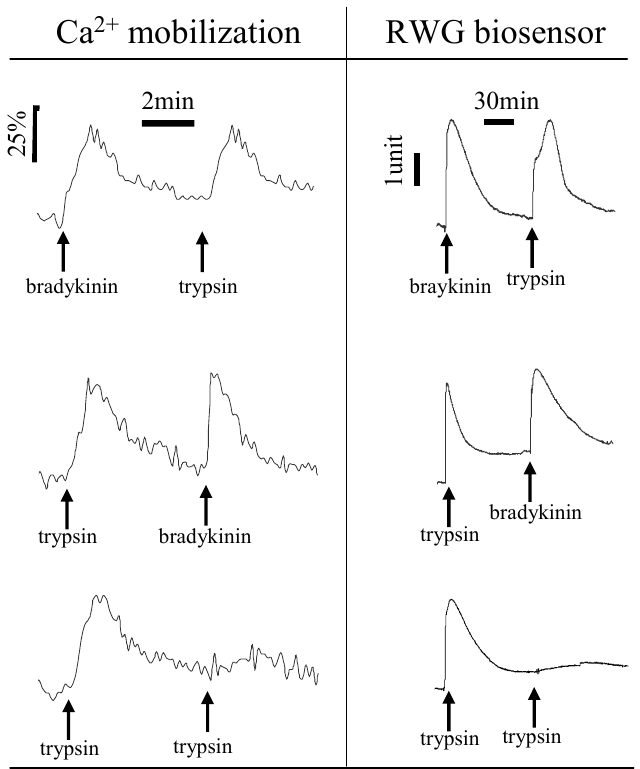
Figure 6 . GPCR agonist-induced DMR signals follow classical desensitization patterns, similar to those measured with Ca 2+ mobilization assays. A431 cells responded to repeated stimulation with distinct combinations of two agonists: bradykinin and trypsin, for endogenous B receptor and protease 2 activated receptor subtype 2 (PAR ), respectively. Data was reproduced with permission from ref. 16 2